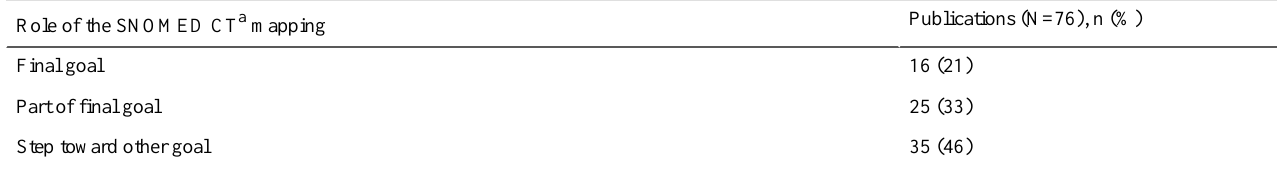
Table 4. Role of the Systematized Nomenclature of Medicine Clinical Terms mapping in the publications.